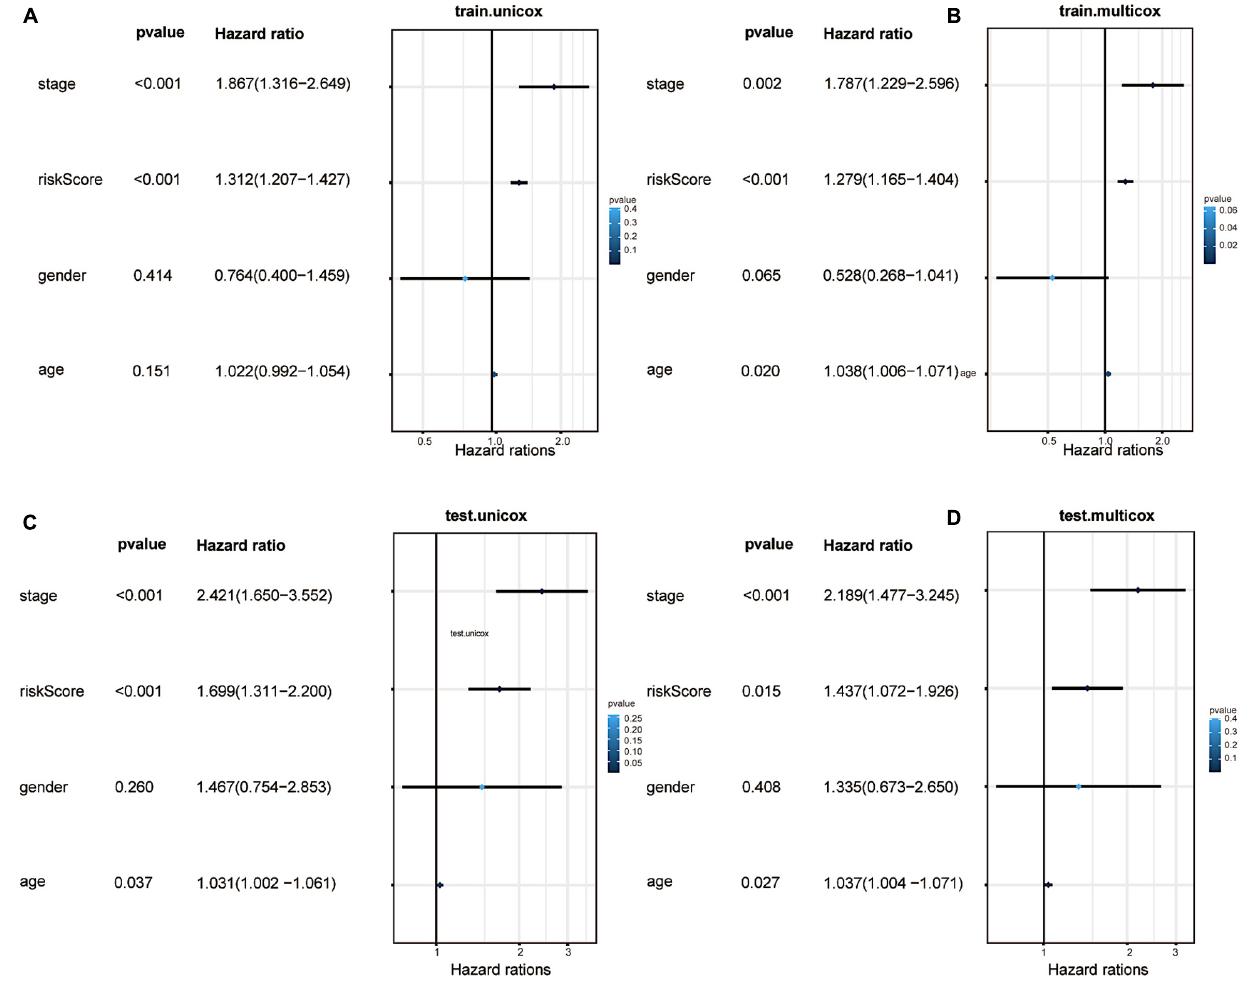
Frontiers in Cell and Developmental Biology |